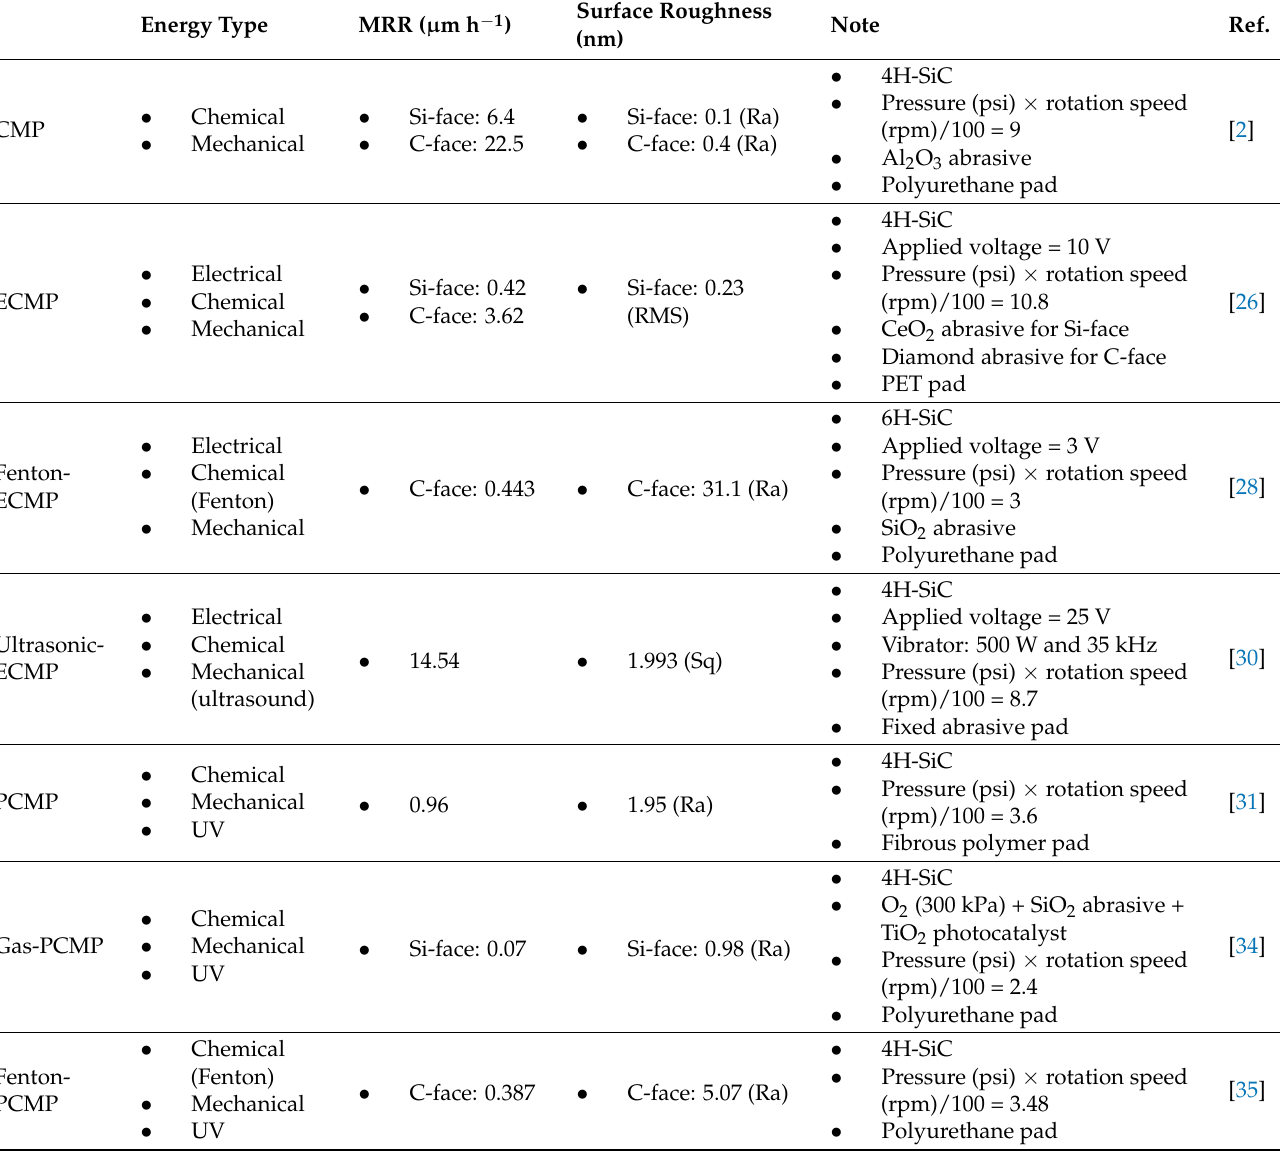
Table 3. Operation conditions and performance parameters, namely MRR and surface roughness, of the various CMP and hybrid CMP technologies discussed in this